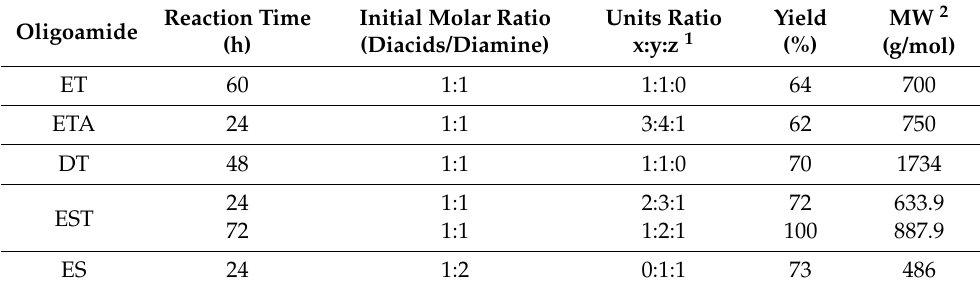
Table 2. Synthesis of non-fluorinated oligoamides performed at 80 ◦ C with methanol as solvent. Reaction Time Initial Molar Oligoamide (h)